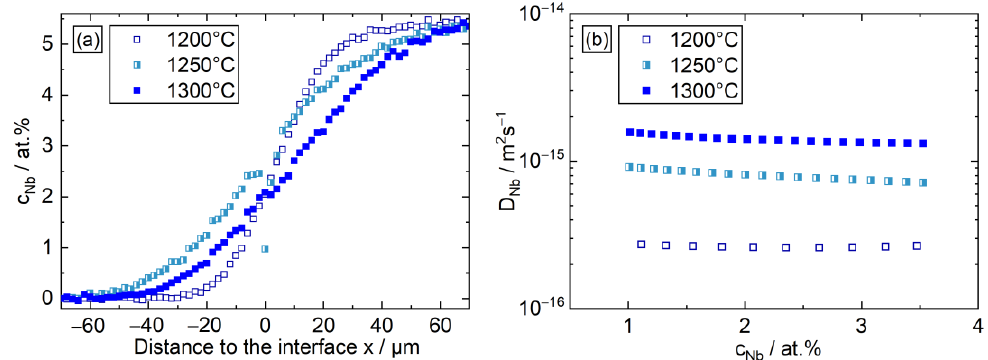
Figure 2. ( a ) Concentration C Nb of Nb across the indentation zone after annealing at 1200 °C, 1250 °C and 1300 °C and ( b ) interdiffusion coefficient D Nb as a function of the Nb concentration C Nb at three different temperatures.